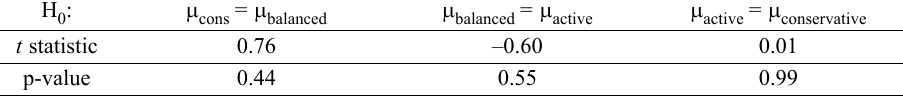
Table 11. Results of hypothesis testing across 3 fund categories (Latvian case)